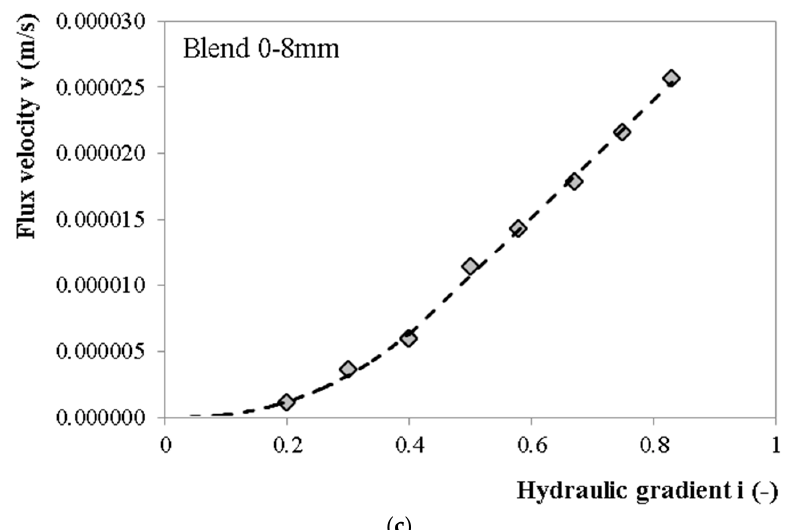
Figure 5. The relationship between the flux velocity and the hydraulic gradient for the blends. ( a ) blend 0.05–16 mm; ( b ) blend 0–16 mm; ( c ) blend 0–8 mm.